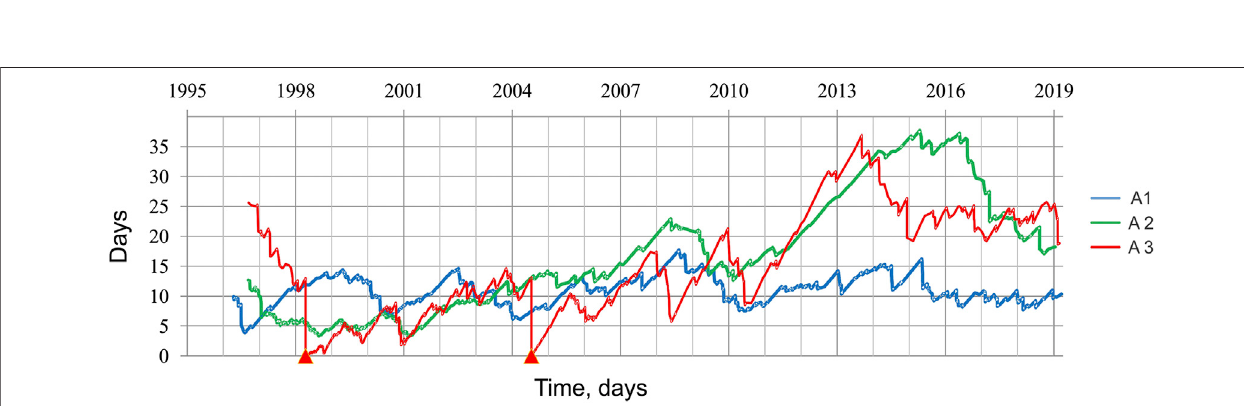
TABLE 3 | The moving average interevent time 〈 τ 〉 trend lines stable intervals for the three FVG sub-regions (1995 – 2019). Sub-region Start time End time Duration,